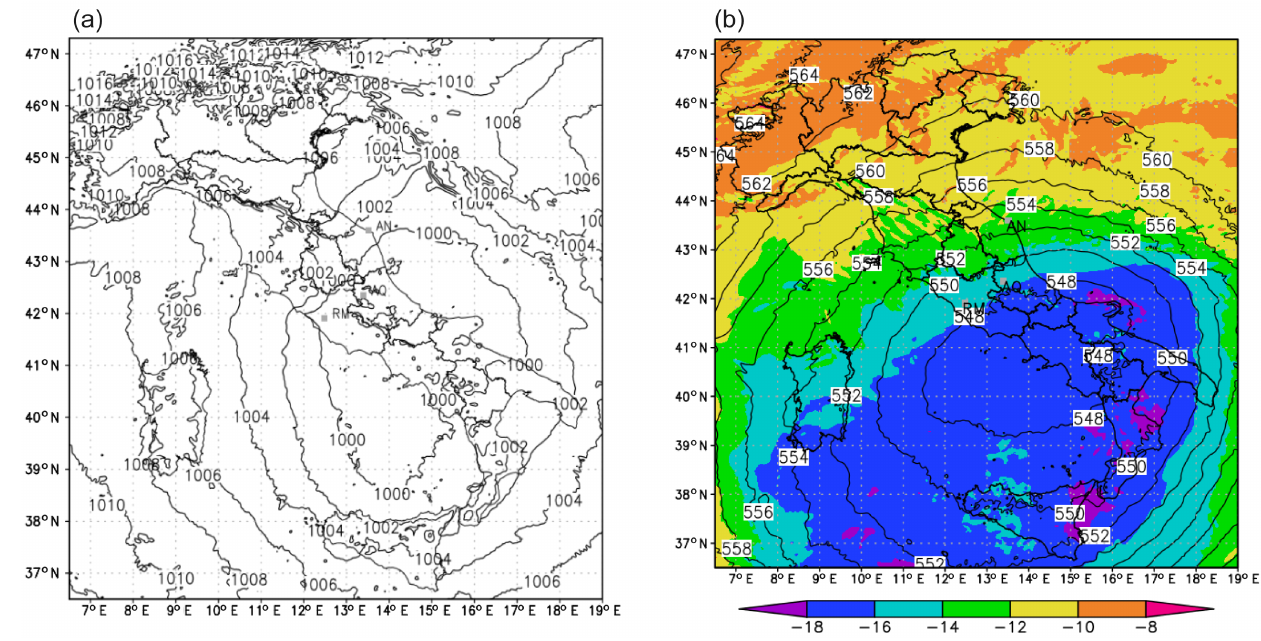
Figure 1. In (a) the surface pressure (hPa) on 14 September 2012 (12:00UTC) is shown. In (b) temperature ( ◦ C) and geopotential height (dam) at 500hPa are presented. The maps have been elaborated considering the ECMWF initial conditions.